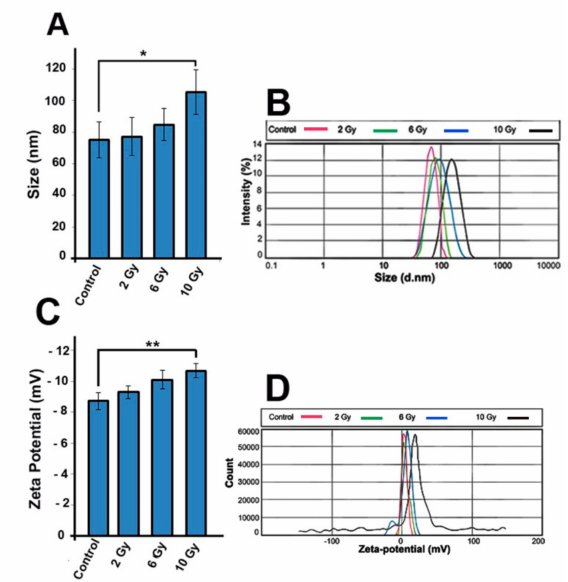
Figure 6. ( A,B ) Size distribution of IR exosomes and ( C , D ) zeta potential of purified exosomes were analyzed by dynamic light scattering (DLS). One-way ANOVA with Tukey test was applied. All values are shown as means ± SD; n = 3. * p < 0.05, * * p <